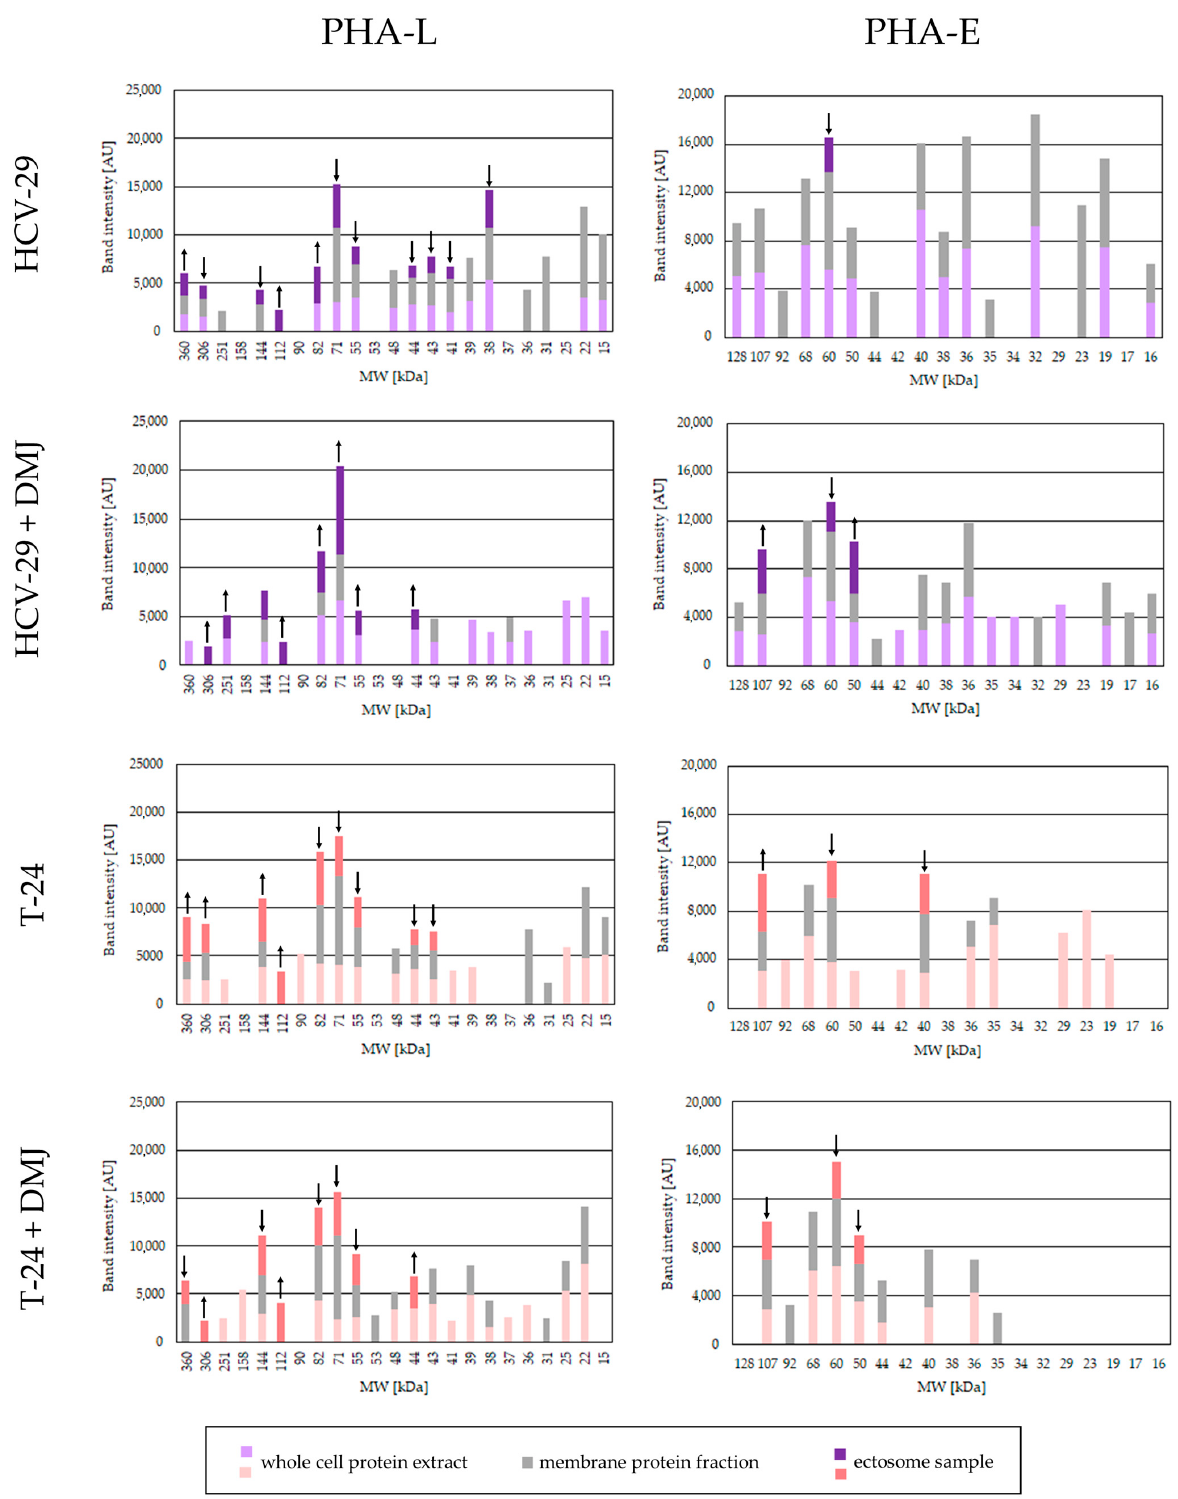
Figure 4. Densitometric analysis of PHA-L- and PHA-E-positive bands. The intensity of detected bands was expressed in arbitrary units (AU) as a peak area on respective densitogram. Each bar represents the intensity of corresponding bands in the whole cell protein extracts, membrane fractions and ectosome samples from each cell line. ↑ and ↓ denote a significant enrichment or depletion, respectively, of a given glycoepitope in the ectosomal fraction compared to membrane fraction. The values from control lectin blots with blocking solutions were subtracted